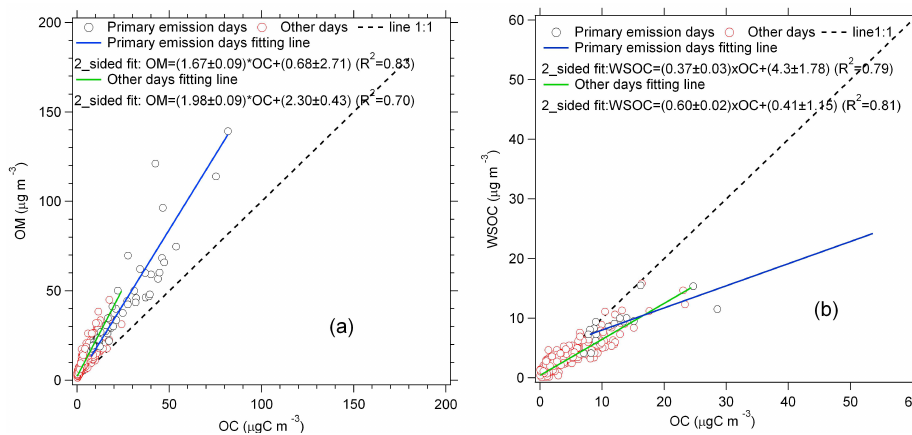
Fig. 4. The correlations of measured data between (a) OM and OC; (b) WSOC and OC.